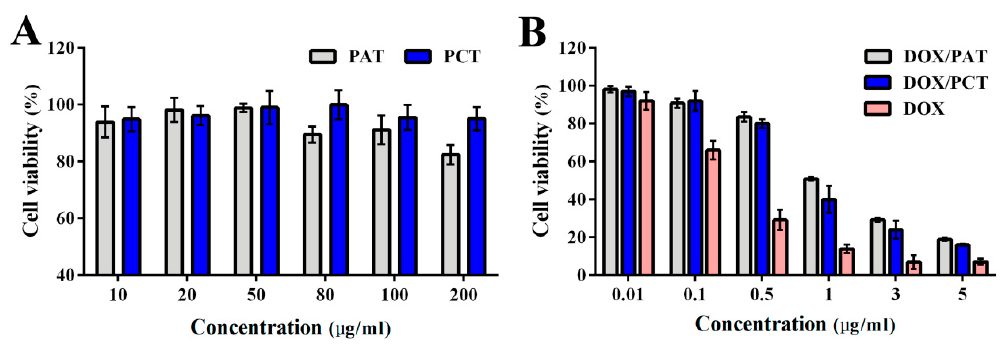
Figure 4. ( A ) Cytotoxicity of PAT and PCT micelles with different concentration, ( B ) cytotoxicity of DOX-loaded micelles and free DOX micelles with different concentration (mean ± SD n =3).